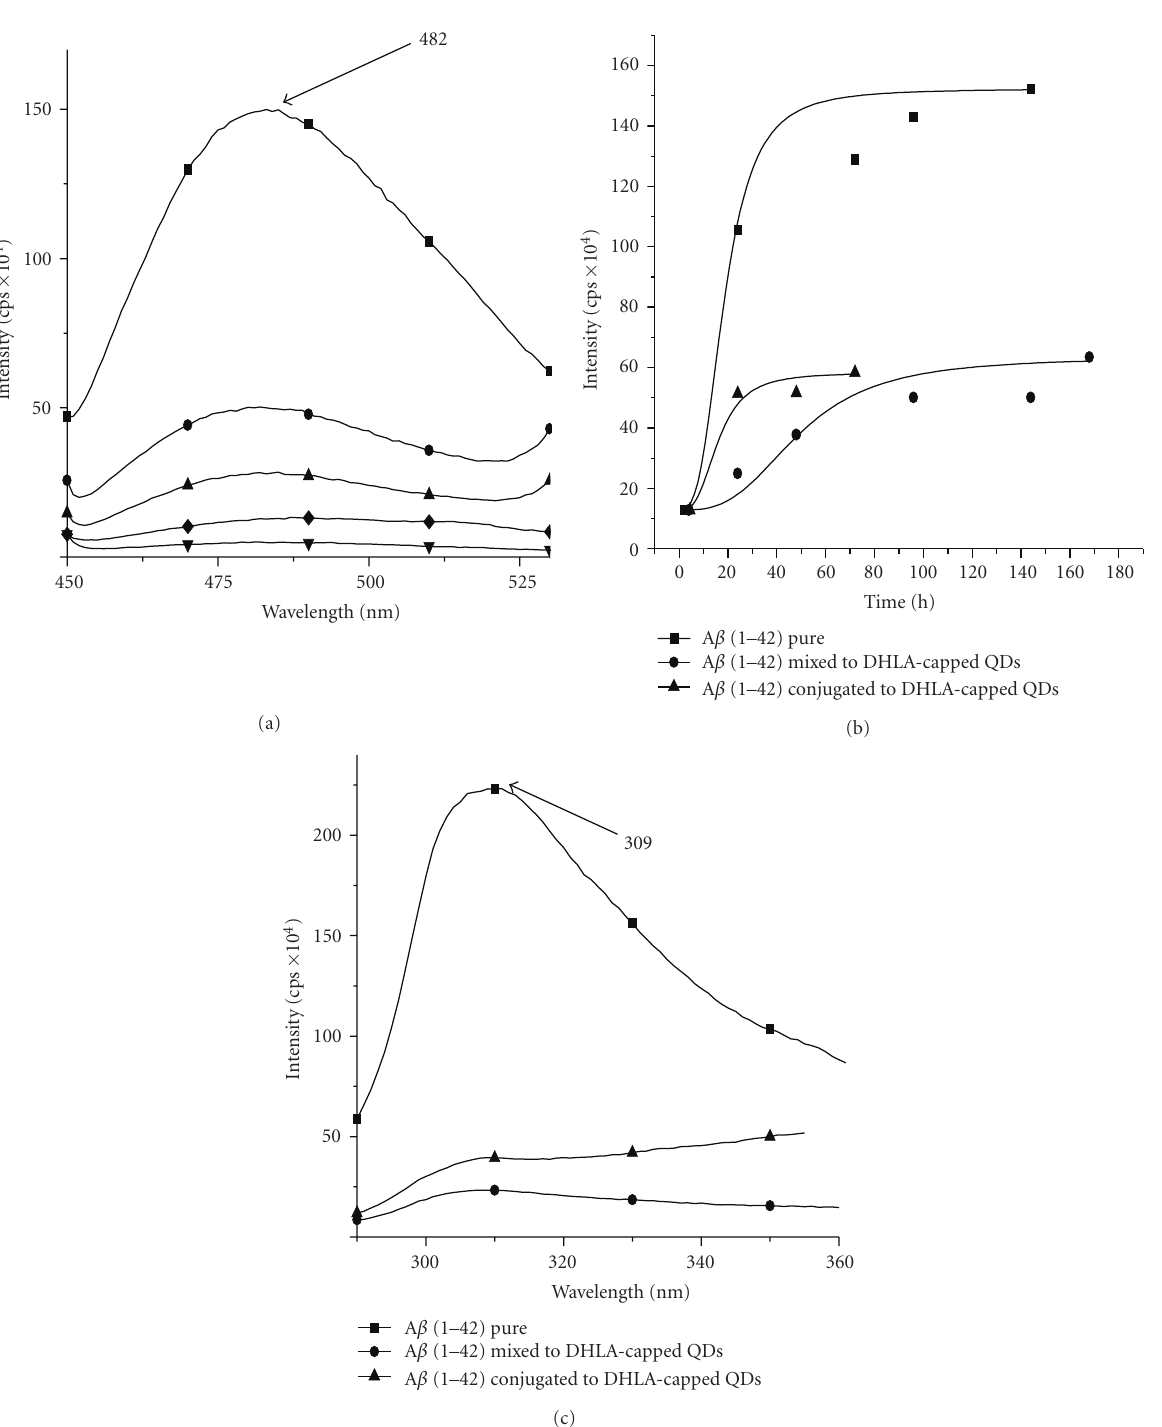
Figure 9: (a) ThT fluorescence after 7 days of incubation at 37 ◦ C for A β (1–42) ( (cid:2) ); ThT assay after 7 days of incubation at 37 ◦ C for A β (1–42) mixed DHLA-capped QDs ( • ); ThT assay after 7 days of incubation at 37 ◦ C for A β (1–42) conjugated DHLA-capped QDs ( (cid:3) );10 μ M Thioflavin T ( (cid:4) ); 0.96 μ M A β (1–42) ( (cid:5) ); (b) thioflavin T fluorescence monitored over a period of 7 days for incubated samples of pure A β (1–42) in comparison to A β (1–42) mixed and conjugated to QDs; (c) tyrosine emission intensity of the A β (1–42) at excitation wavelength 280nm, quenched in the presence of